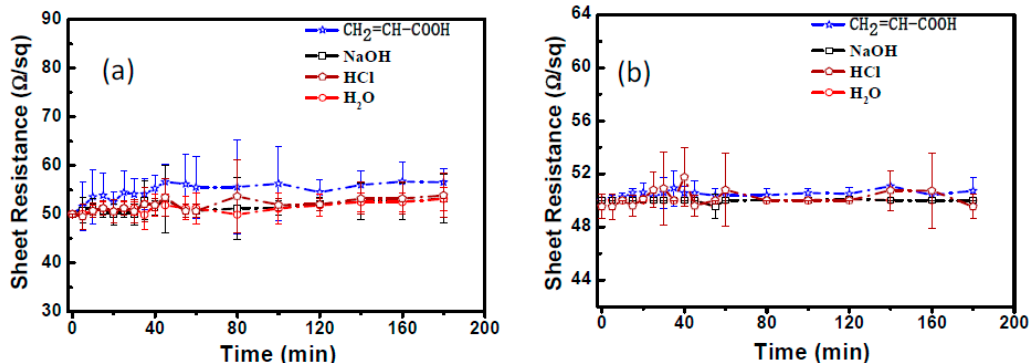
Figure 3. Sheet resistance variation of AgNW TCFs during liquid chemical etching ( a ) without and ( b ) with the 90 min treatment through FeCl 3 -DS.